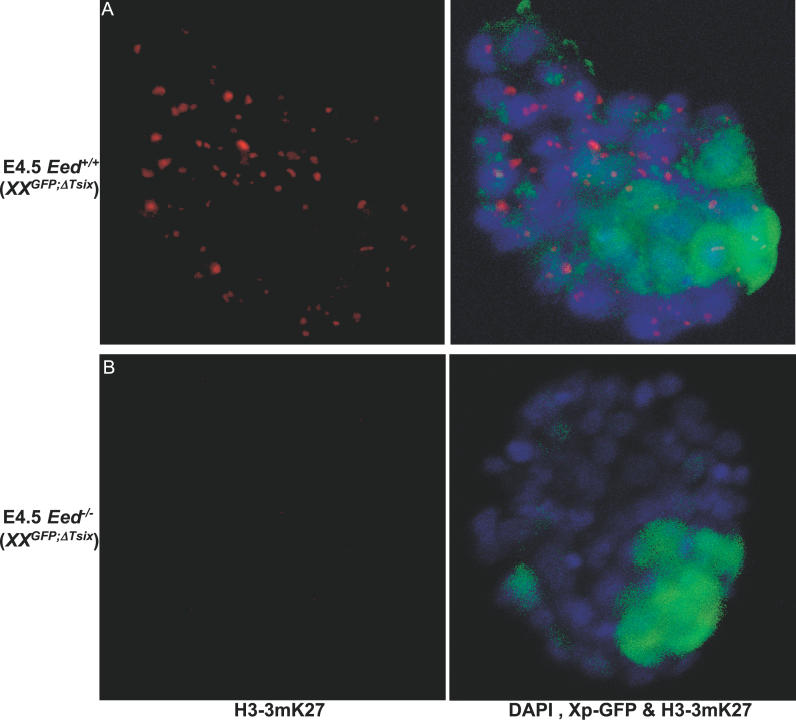
Absence of EED Activity prior to the Initiation of Random XCI in Eed
−/− Embryos(A) IF detection of H3-3mK27 in a WT E4.5 embryo shows H3-3mK27 enrichment on the Xi in all trophectodermal cells, but which is largely absent in the ICM/epiblast cells indicating that these cells have not undergone random XCI. The selective expression of the paternal X-linked GFP transgene (Xp-GFP) in the ICM lineage indicates that these cells have erased the imprint that ensures imprinted XCI of the Xp. Whereas the ICM has erased the imprint, the trophectoderm has stably maintained imprinted XCI of the Xp, and hence is negative for Xp-GFP. DAPI staining detects the nuclei.(B) IF staining showing a lack of histone H3-3mK27 accumulation on the Xi in all cells at E4.5, indicating that EED activity is absent in mutant embryos prior to the initiation of random XCI.